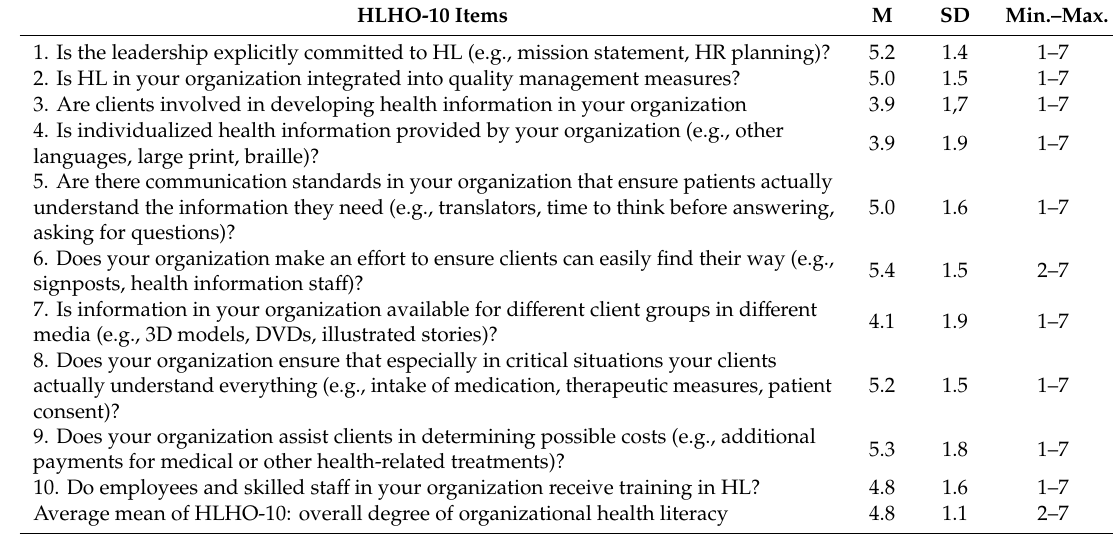
Table 2. Descriptive statistics of the organizational health literacy (OHL) attributes (N = 130).